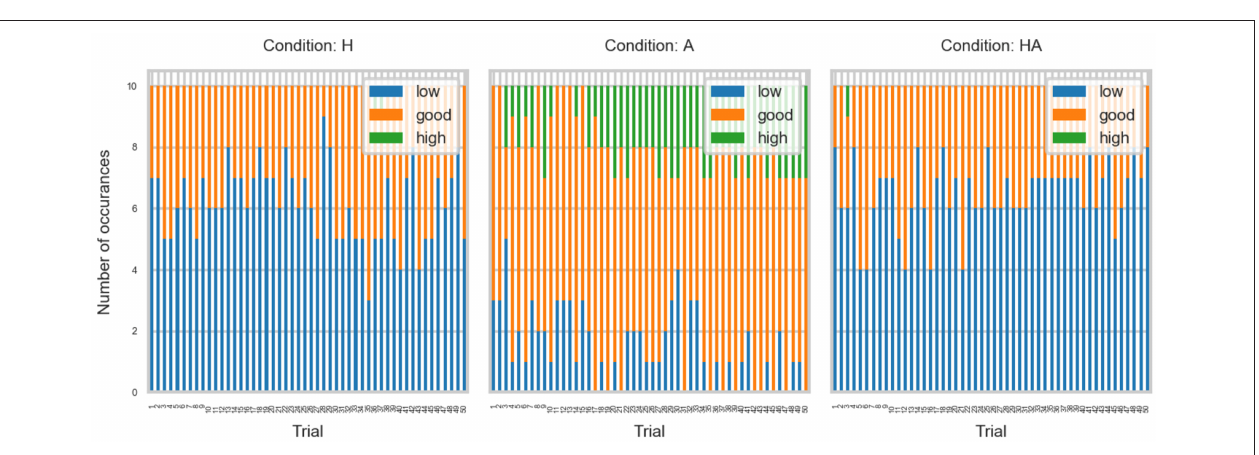
FIGURE 4 | Feedback labels for the haptic (H), acoustic (A), and haptic-acoustic (HA)